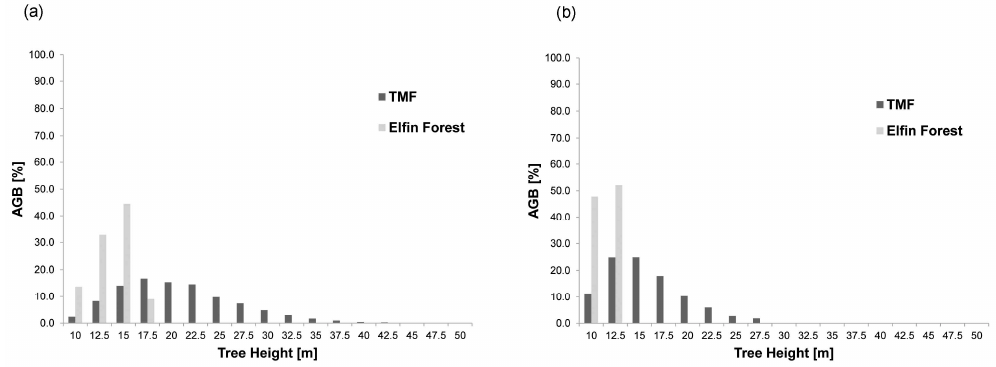
Figure 10. Portion of total AGB of the established H classes; ( a ) ravine forest, ( b ) ridge